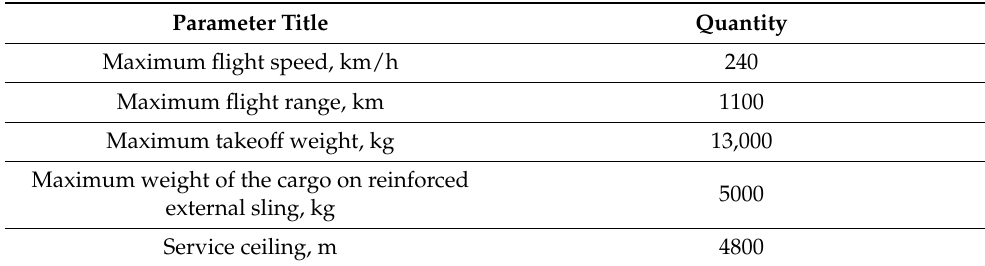
Table 1. Main technical characteristics of the Mi-8MTV helicopter